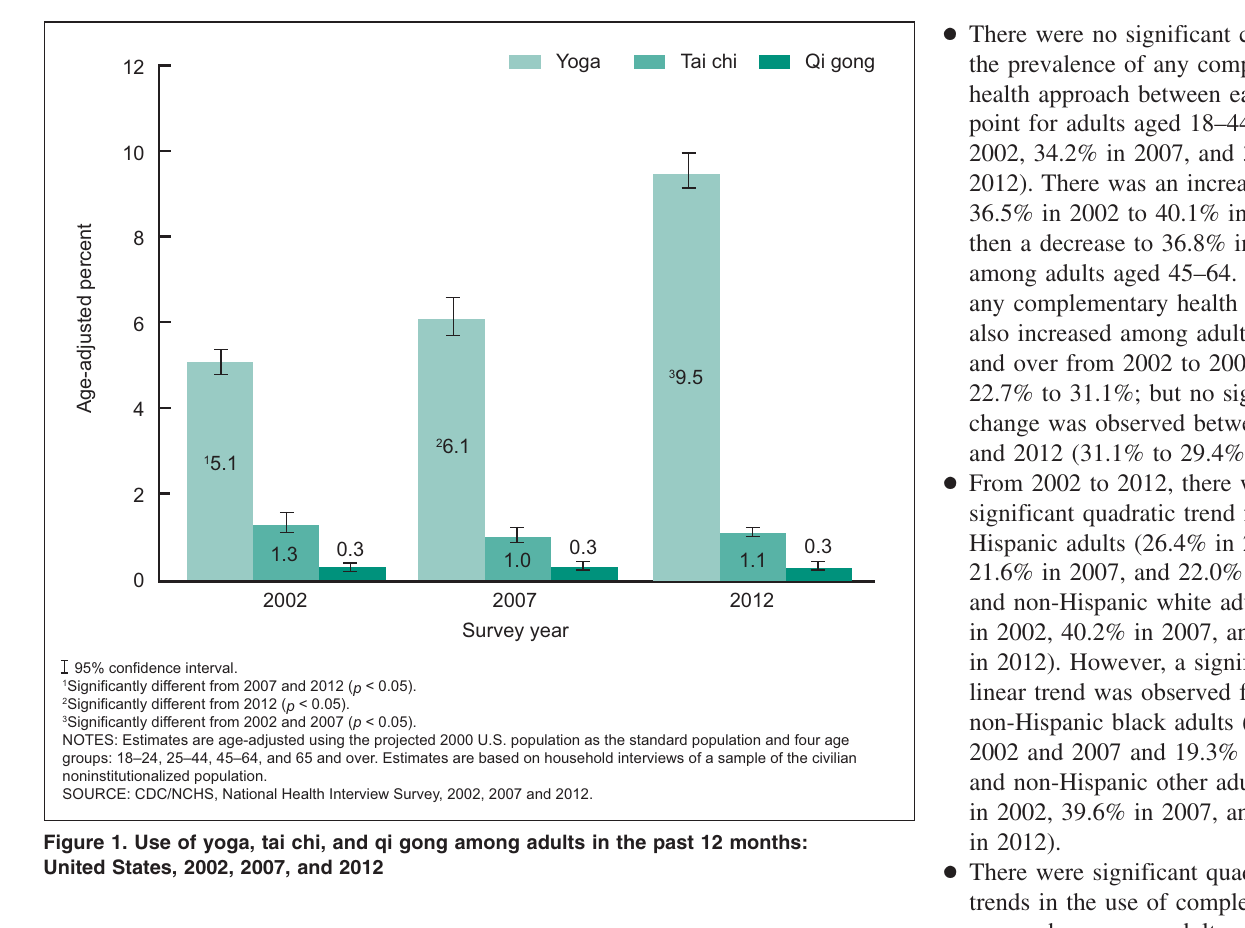
manipulation was the fourth most commonly used approach in 2002 (7.5%), 2007 (8.6%), and 2012